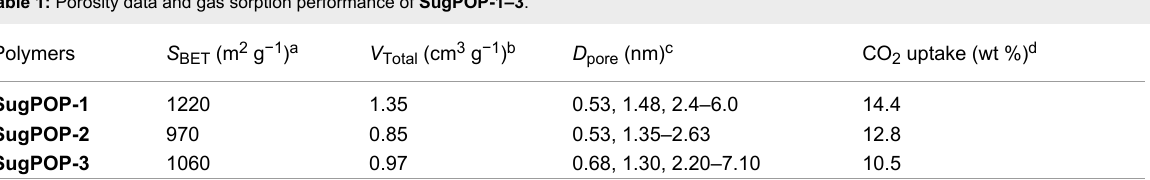
Table 1: Porosity data and gas sorption performance of SugPOP-1–3 . Polymers